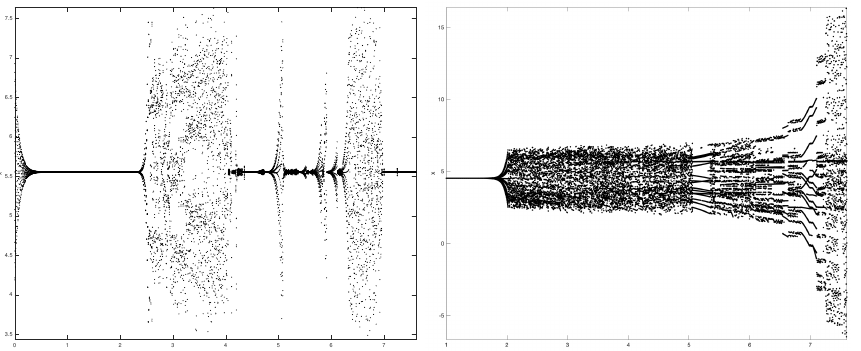
Figure 10. Bifurcation diagrams for the map that considers together fundamentalist, and chartist demands. The diagrams are presented with respect to e . ( left ) shows the diagram with a = 1.1, b = 0.8, c = 1 and e ∈ [ 0,7.6 ] . ( right ) shows the diagram with a = 0.9, b = 0.8, c = 1 b